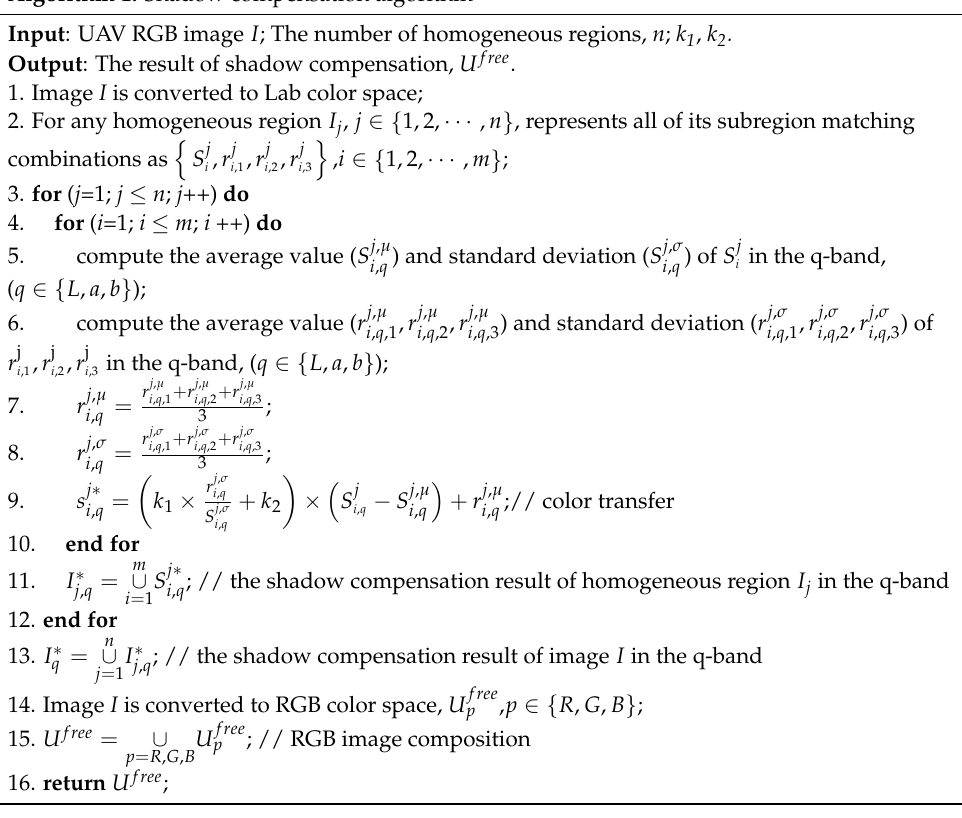
Algorithm 1. Shadow compensation